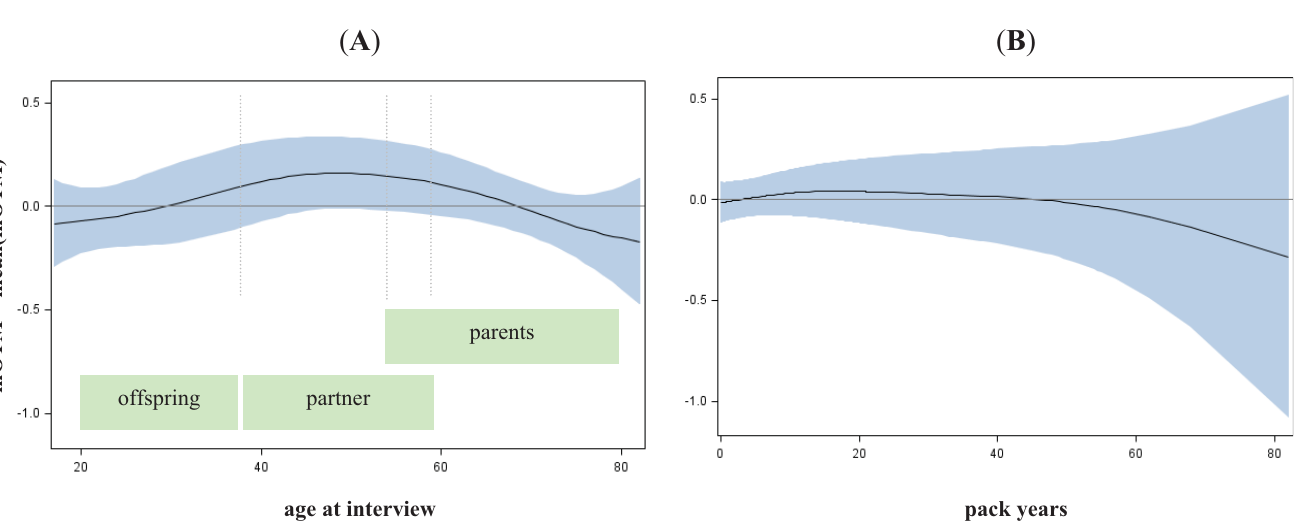
Figure 2. Alteration of basal damage along age ( A ) and pack years ( B ). Spline with df = 2 and 95% – confidence interval adjusted for age, gender and smoking.